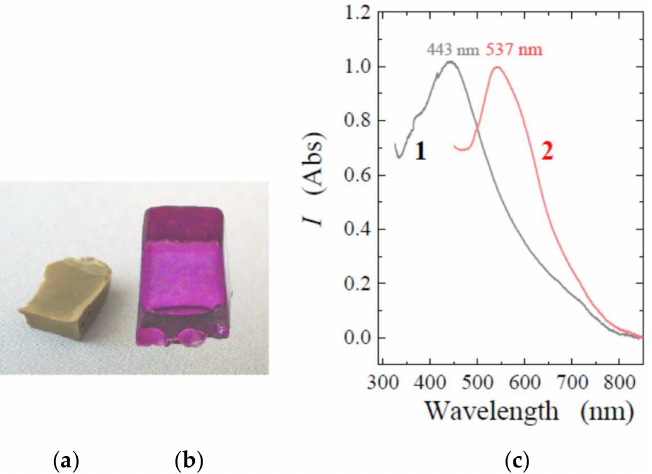
Figure 5. ( a ) Silica coated with excess silver. The sample was obtained on TA@SiO 2 without washing from polyphenol after the sol-gel synthesis. ( b ) Silica containing gold nanoparticles in the internal volume. The sample was synthesized after preliminary washing in a solution containing 0.1 wt%